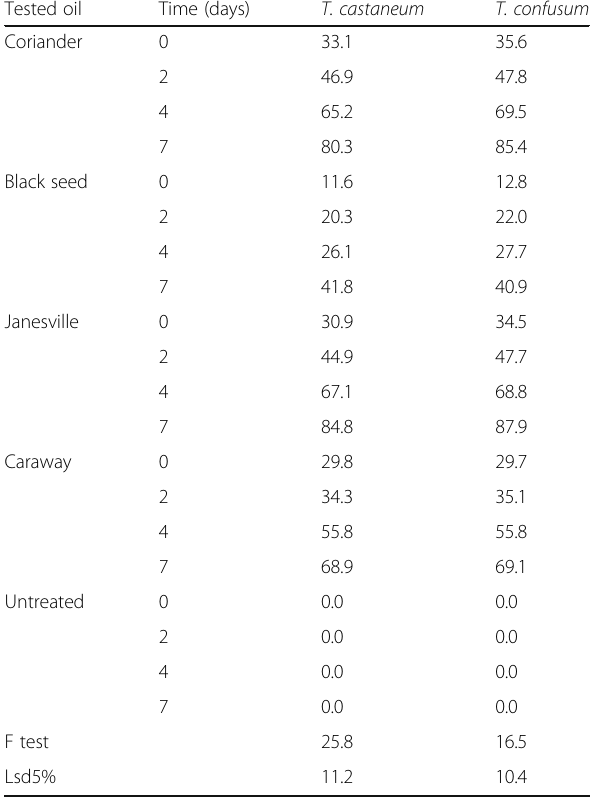
Table 1 The accumulative mortality of T. castaneum and T. confusum during the first week of treated foam with different tested oils Tested oil